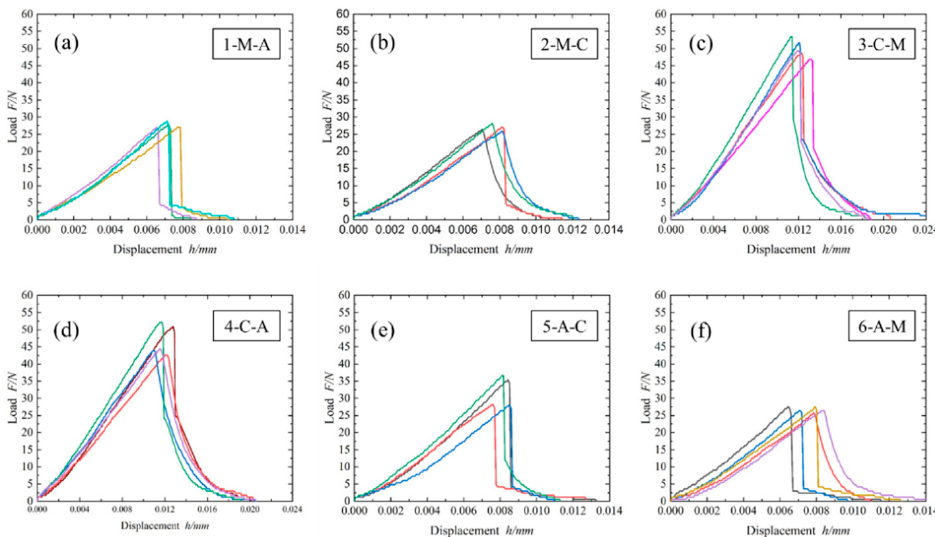
Figure 5. Displacement-load curves of each test group. ( a ) Test 1-M-A; ( b ) Test 2-M-C; ( c ) Test 3-C-M; ( d ) Test 4-C-A; ( e ) Test 5-A-C; ( f ) Test 6-A-M.